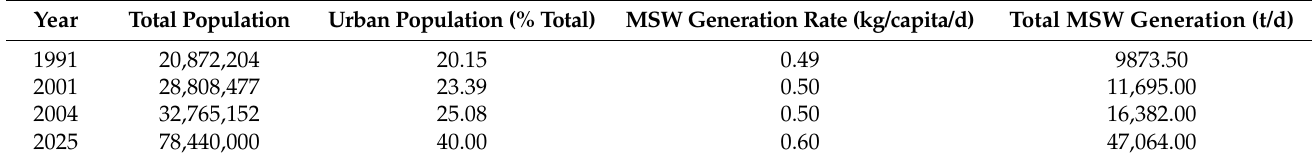
Table 3. Growth rate of MSW in urban cities of Bangladesh in the last few years [24].